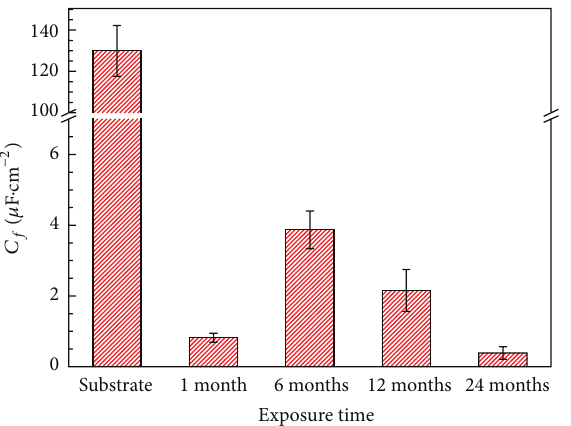
Substrate Figure17:Thecalculatedcapacity 𝐶 𝑓 ofthecorrosionproductsafter immersion in 0.1M NaCl for 0.5